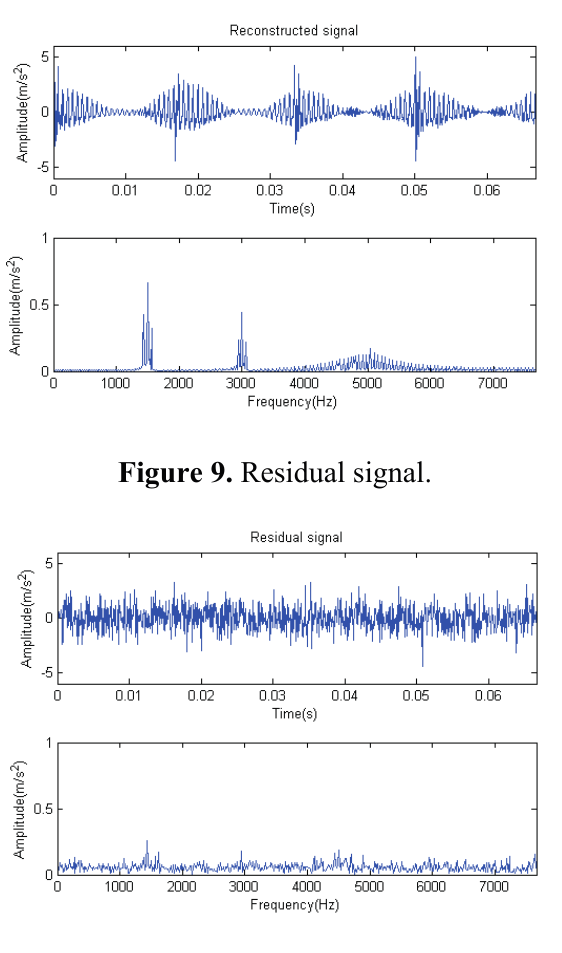
Figure 8. Reconstructed signal.